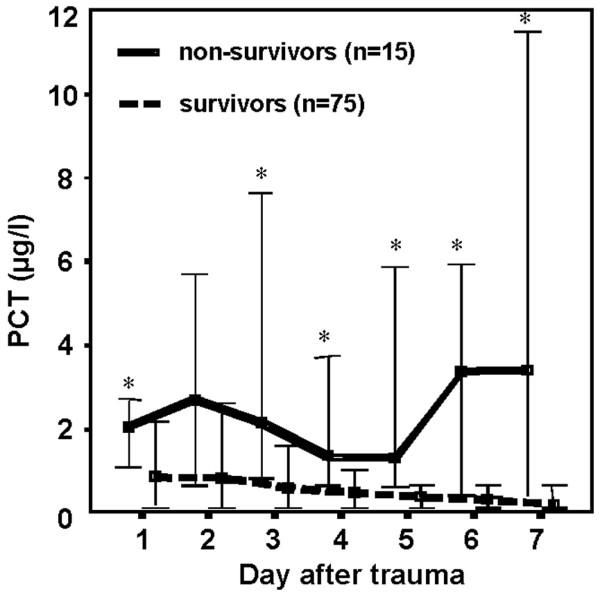
Course of procalcitonin (PCT) (median, quartiles) during the first week after trauma in nonsurvivors (n = 15) and in survivors (n = 75). *P < 0.05, Mann–Whitney U test.